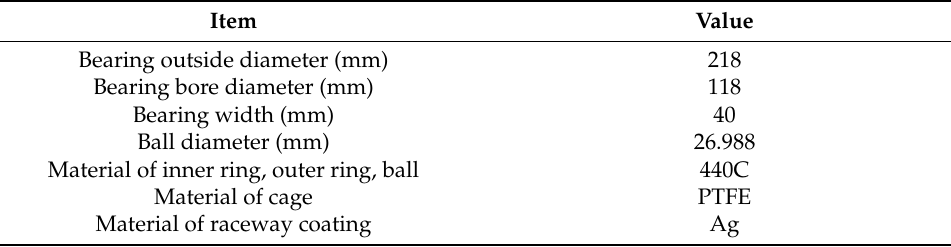
Table 3. Major parameters of ball bearings for cryogenic